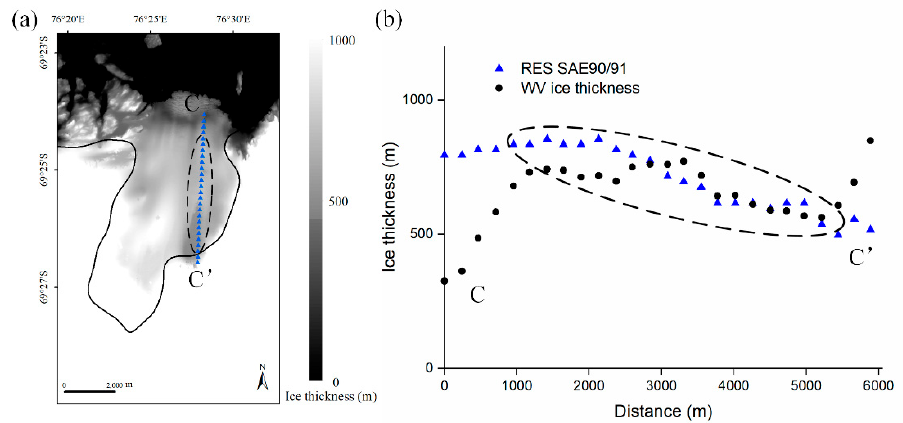
Figure 7. ( a ) Ice thicknesses of Dalk Glacier derived from WVDEM. Triangle points denote the locations of radio-echo sounding (RES) data. Points in black ellipsoid indicate floating regions, while others reveal grounded regions. ( b ) Comparison between RES and WVDEM-derived ice thickness. Points in black ellipsoid correspond to points marked with ellipsoid in (a).